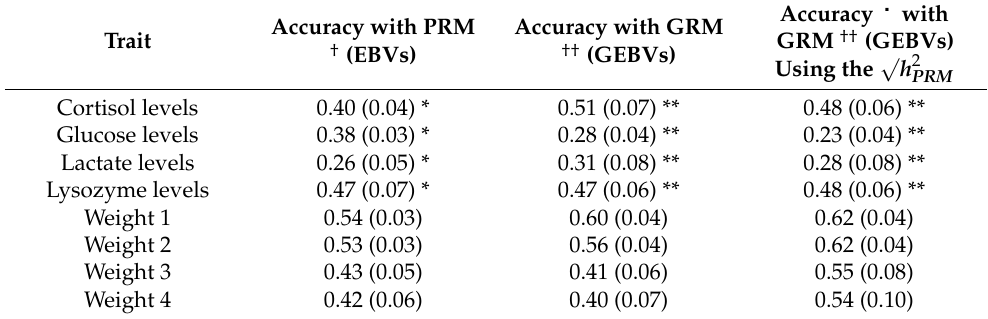
Accuracy calculated using